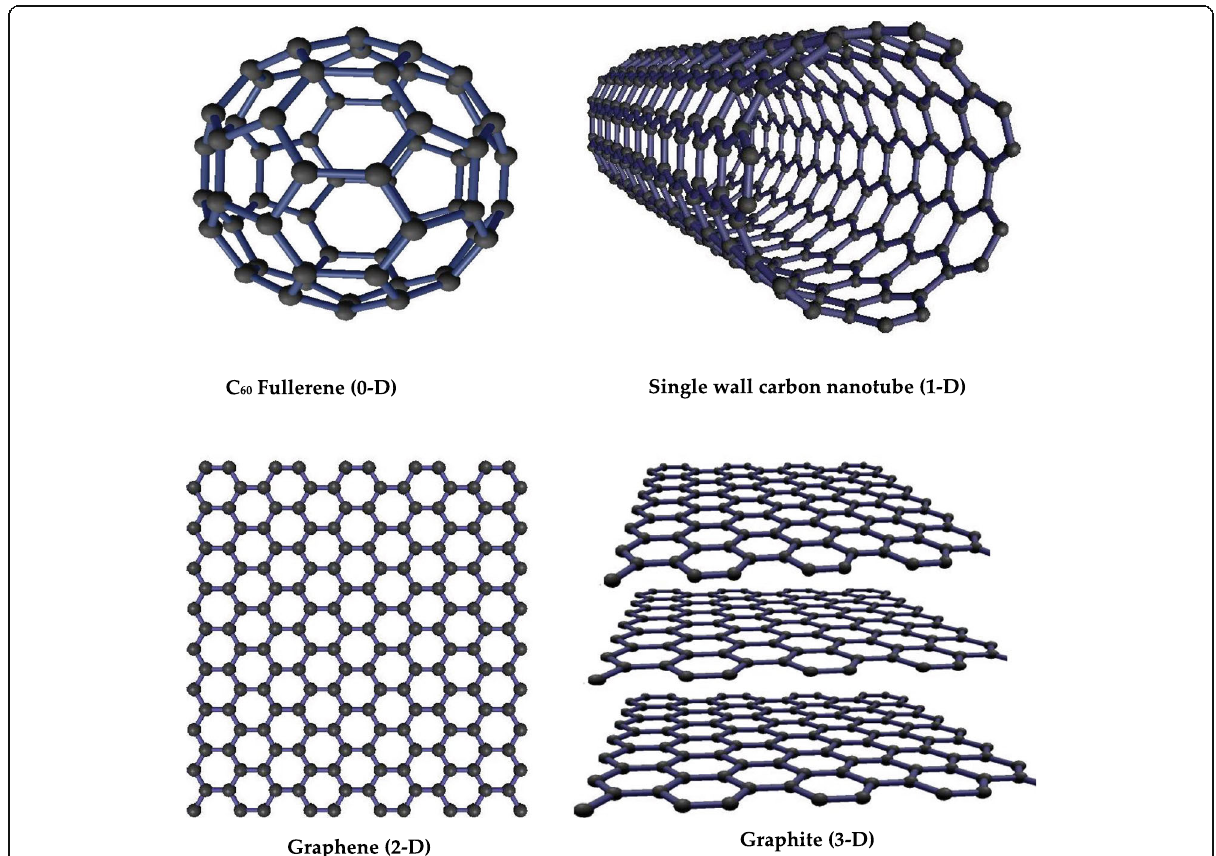
Fig. 3 The examples of carbon nanomaterial of different